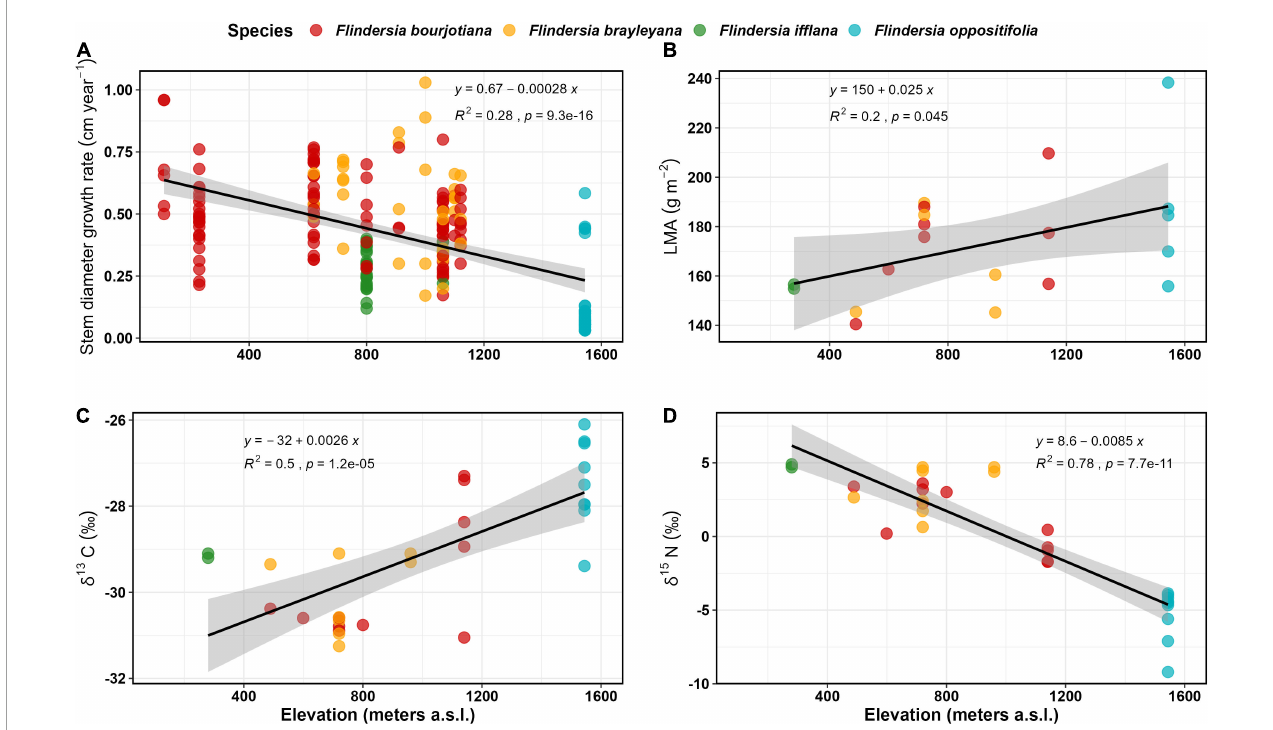
FIGURE2 Field observed trends for (A) Stem diameter growth rates (cm year − 1 ) (data and model predictions are square root transformed) ( n = 195); (B) Leaf mass per unit Area (g m − 2 ) ( n = 20); (C) Leaf δ 13 C ( gradient in the Australian Wet Tropics.